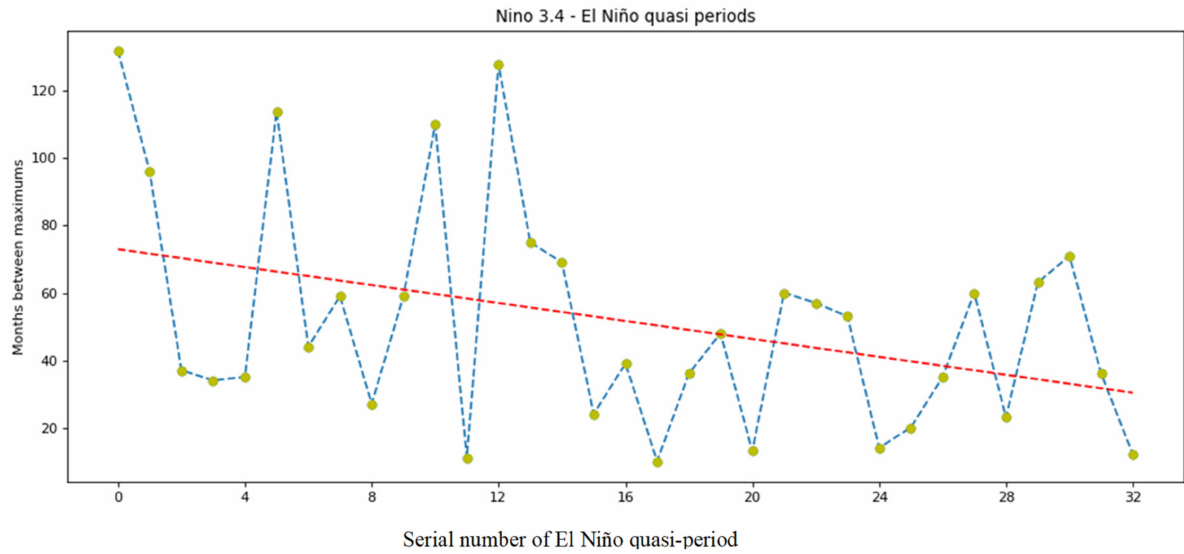
Figure 3. Illustration of quasi-periodicity (time between consecutive maxima of El Niño episodes), based on Table S1. Numbers of episodes follow from this table. In this and following plots of quasi-periodicity, a regression line is added in